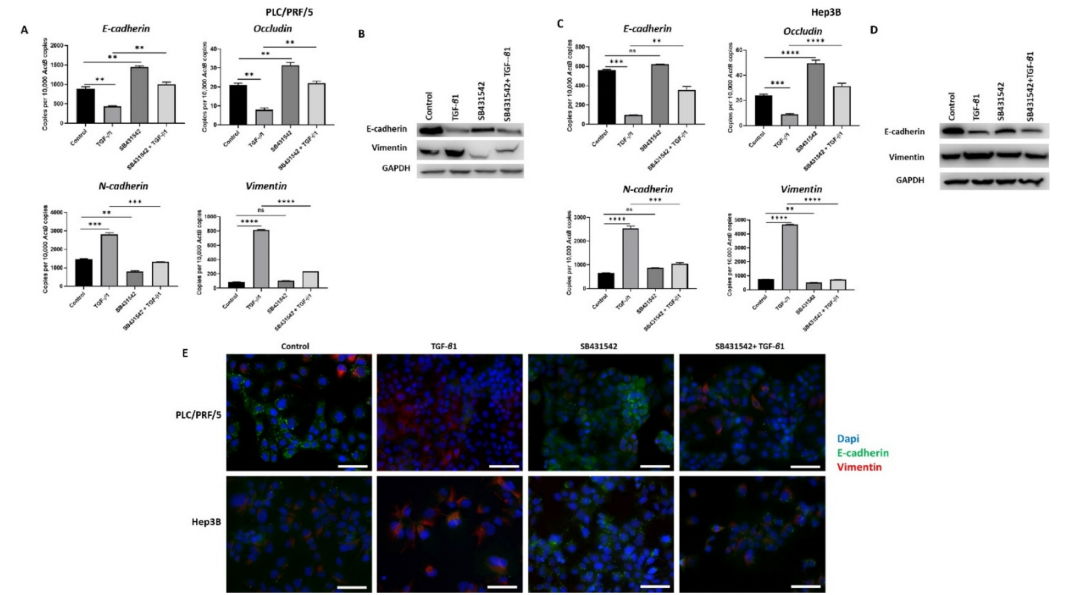
Figure 3. SB431542 inhibits TGF- β 1-mediated EMT in HCC cells. ( A ) qRT-PCR revealed an increase in E-cadherin and Occludin and a decrease in N-cadherin and Vimentin expression and ( B ) western blot showed an increase in E-cadherin and reduction in Vimentin following TGF- β 1 and SB431542 treatments compared with cells treated with TGF- β 1 alone in PLC/PRF/5 cells. GAPDH was used as the loading control. ( C ) qRT-PCR revealed increased expression of E-cadherin and Occludin and lower expression of N-cadherin and Vimentin and ( D ) western blot analysis demonstrated higher expression of E-cadherin and lower expression of Vimentin following treatment with TGF- β 1 and SB431542 in Hep3B cells. GAPDH was used as the loading control. ( E ) Fluorescence microscopy demonstrated upregulation of E-cadherin and downregulation of Vimentin in cells treated with TGF- β 1 and SB431542 compared with cells treated with TGF- β 1 alone in both PLC/PRF/5 and Hep3B cells (scale bar = 200 µ m) ( n = 3, ** p < 0.01, *** p < 0.005, **** p < 0.001, ns: not significant).